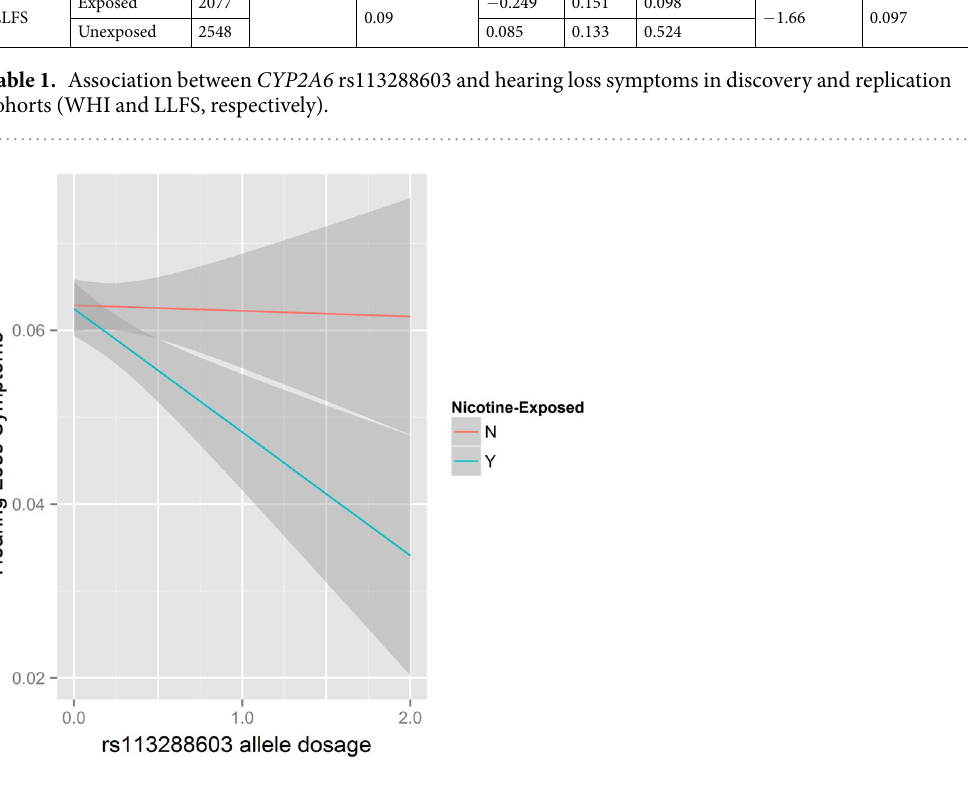
Figure 1. Differences in the association between CYP2A6 rs113288603 * T and hearing loss symptoms in nicotine-exposed and nicotine-unexposed subjects from the WHI